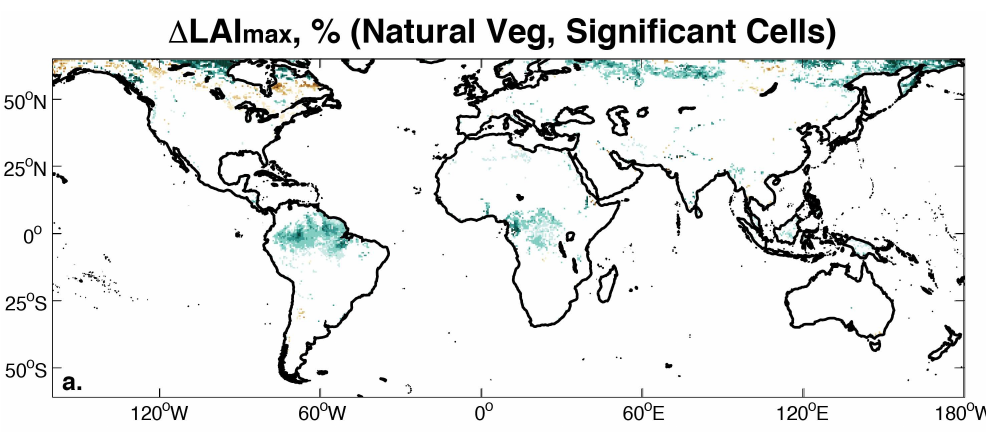
Figure 7. Percent change in LAImax (1982–2008) for all ( a ) natural ( < 10% pasture cover) and ( b ) pasture ( ≥ 10% pasture cover) vegetated cells, with insignificant regions masked based on the three trend test criteria. Cells with ≥ 30% cultivated crop fractions have been masked